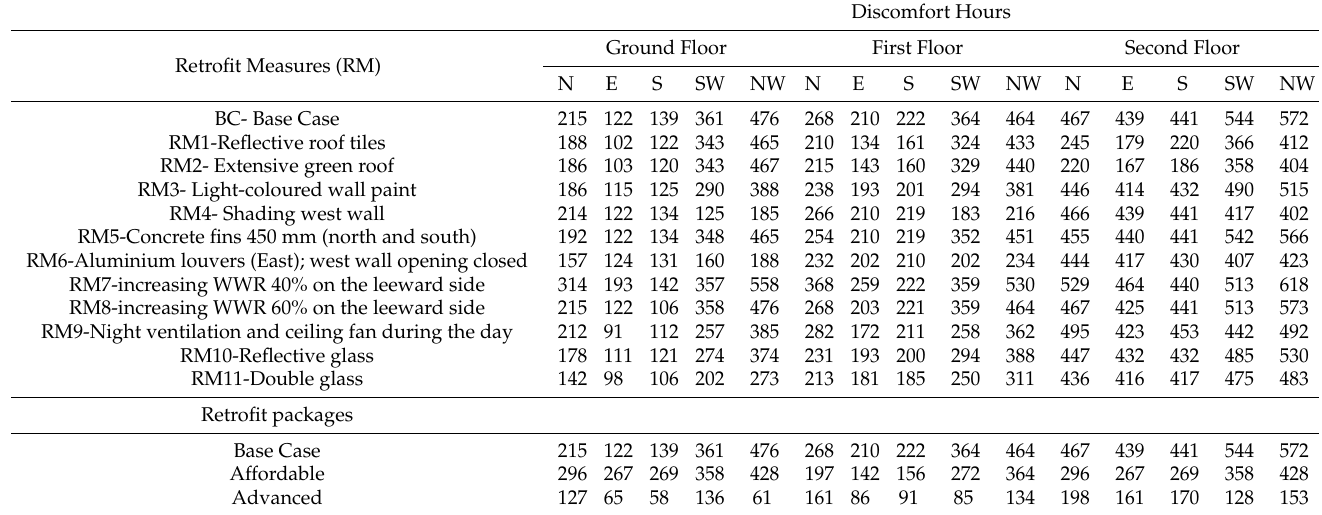
Table 3. Discomfort hours at each floor level and building orientation for various envelope retrofit